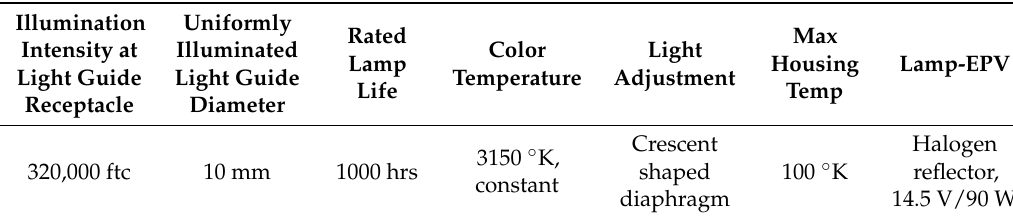
Figure 2. In situ image acquisition and measurement system. Table 2. The specifications of Volpi Intralux Model